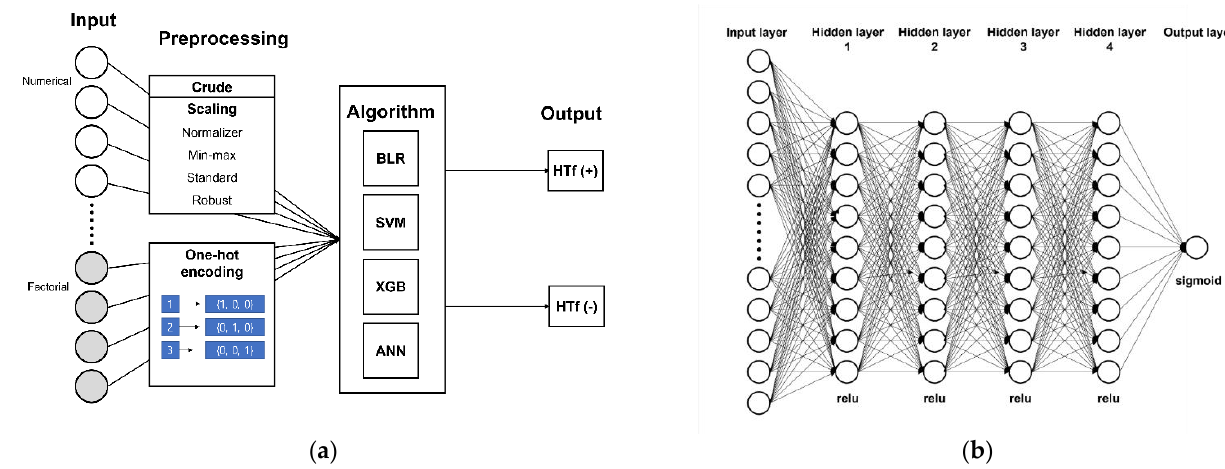
Figure 2. Schematic representation of the machine learning model: ( a ) the preprocessing process of the categorical and continuous variables and ( b ) the schematic representation of the artificial neural network structure. BLR: binary logistic regression; SVM: support vector machine; XGB: extreme gradient boosting; ANN: artificial neural network; HTf: hemorrhagic transformation; and relu: rectified linear unit.